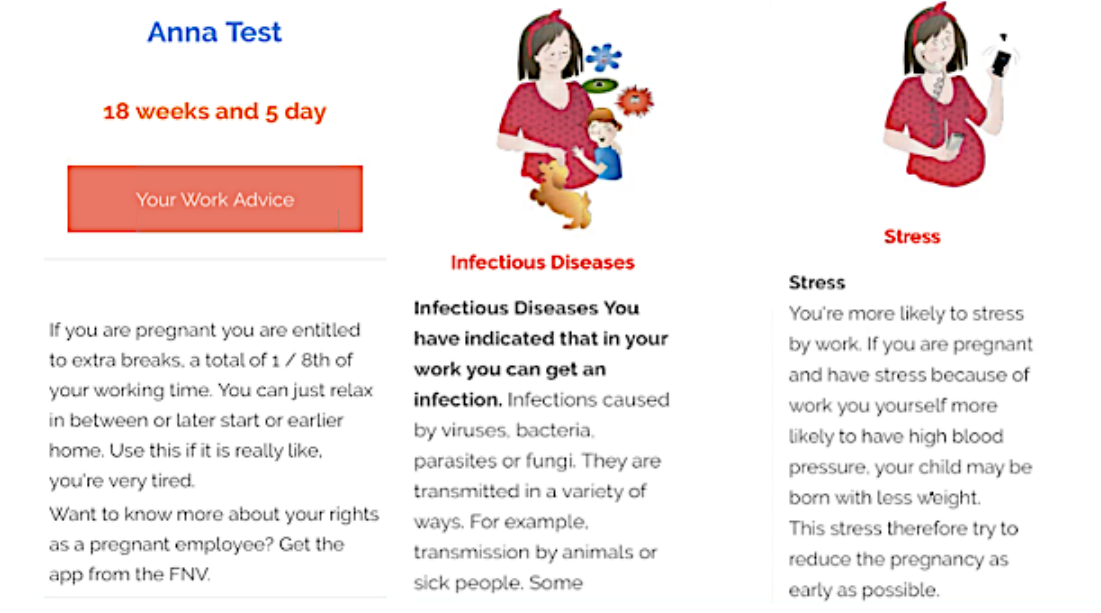
Figure 4. The “Your Work Advice” button on the home page with examples of work advice (infectious diseases and stress) when the button is